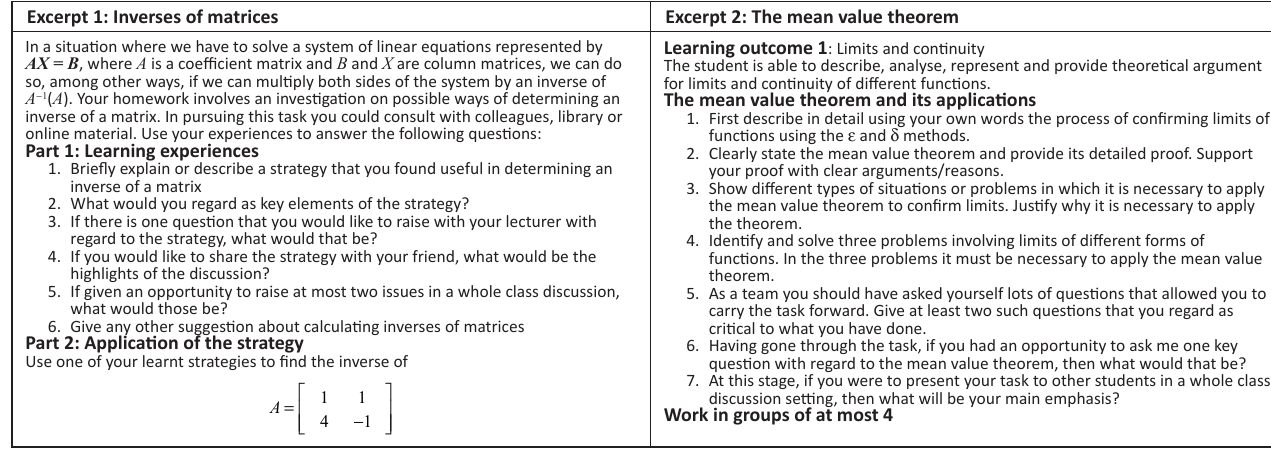
Figure 3 captures two excerpts from his teaching in a Year 2 class for a Bachelor of Education in Senior Phase and FET teaching programme.